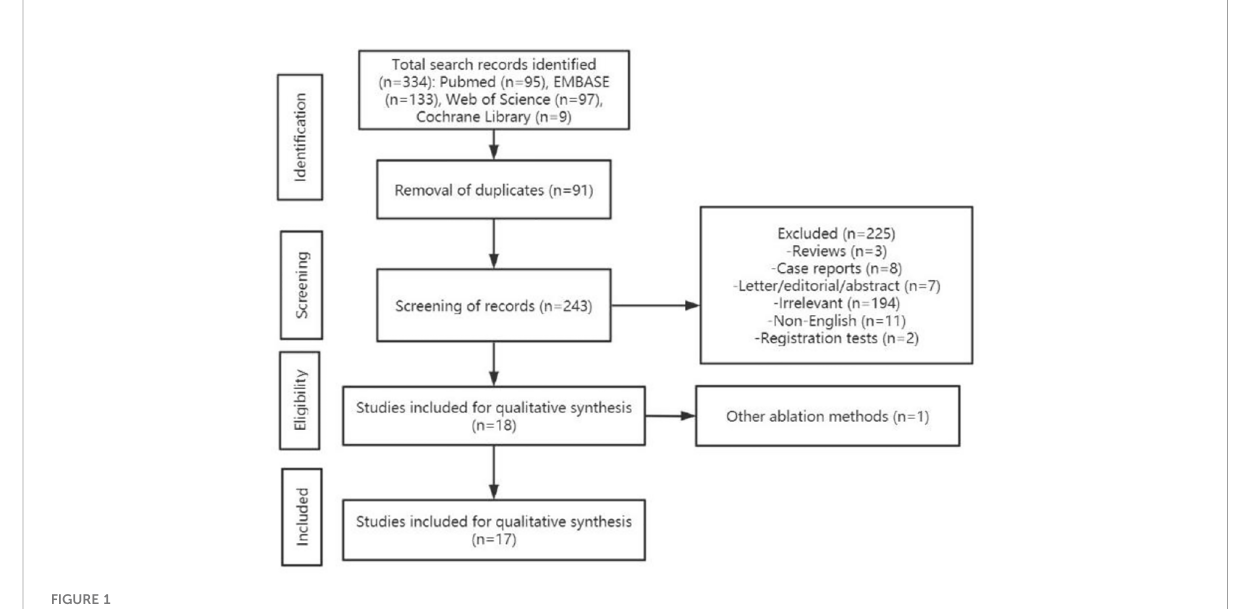
FIGURE 1 Flow diagram of the study selection process.